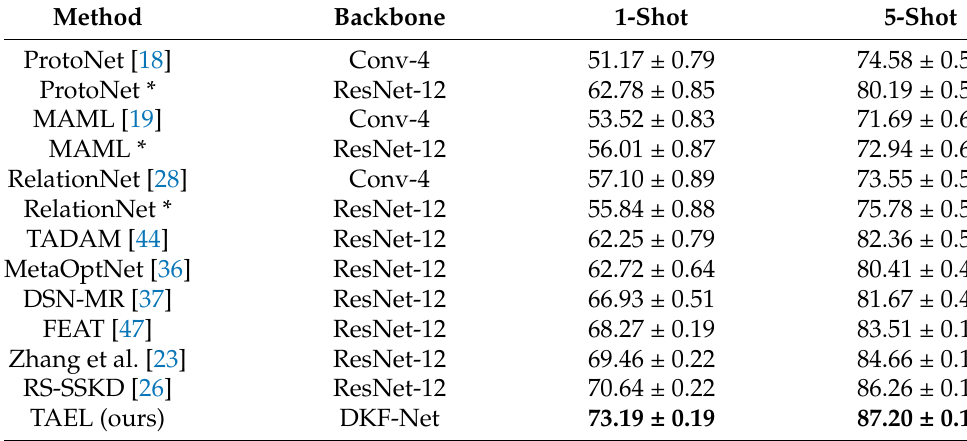
Table 4. Comparison to previous works on NWPU-RESISC45. Average 5-way few-shot classification accuracy (%) is reported with 95% confidence intervals. The symbol * denotes the backbone of the original model is replaced with ResNet-12, and the results are reported in [23]. The best results in each column are marked in bold.